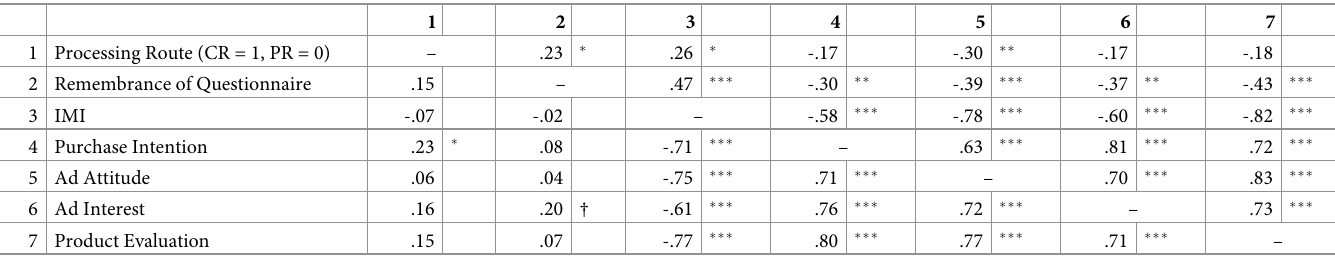
Table 3. Zero-order correlations in each forewarning